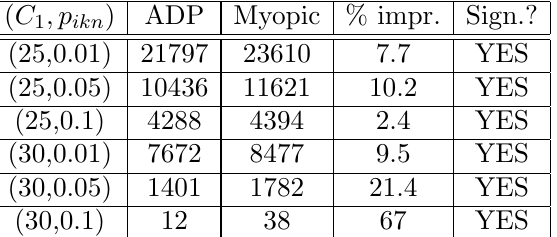
Table 7. Results for the relaxed tol- erance high late scheduling case with N = 10.